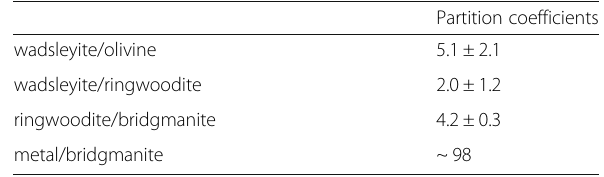
Table 3 Nitrogen partition coefficients among lower mantle silicate phases (data from Yoshioka et al. 2018)